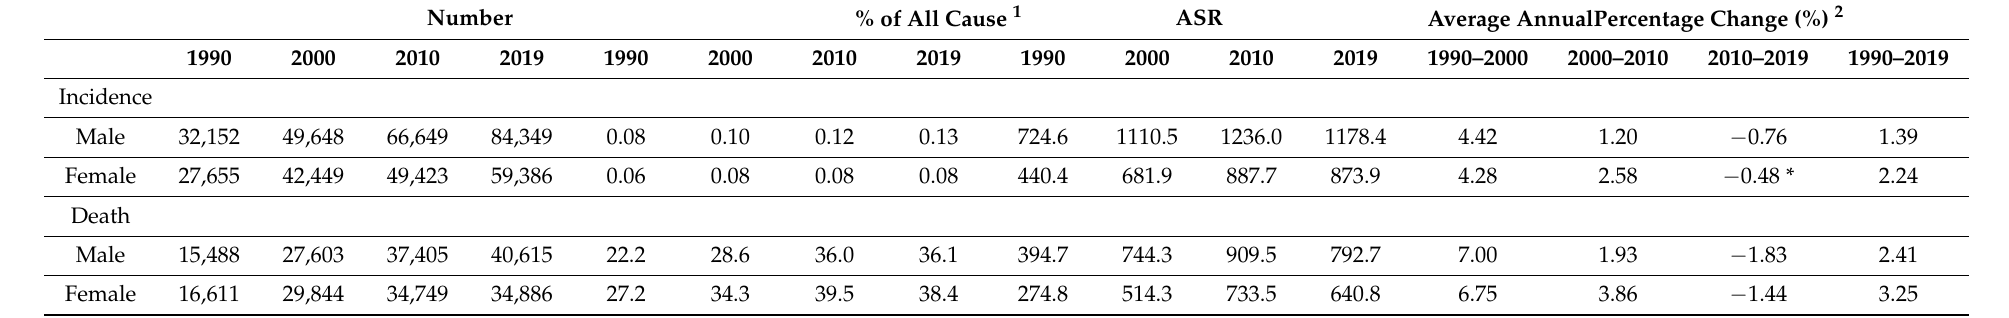
Table 2. Death and incidence of ischemic heart disease in